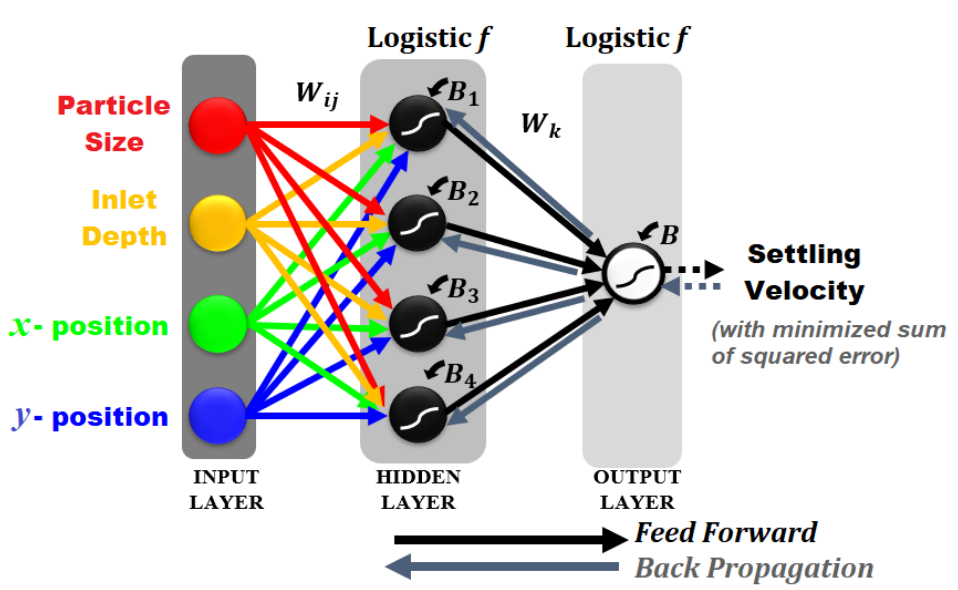
Figure 4. Network architecture of the proposed BPNN.